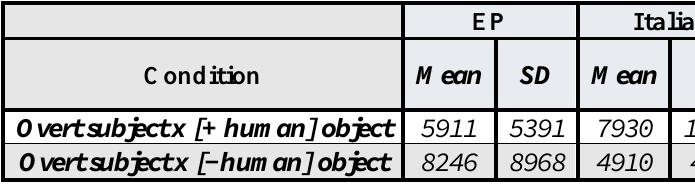
Table 4. Response times (in milliseconds) in the speeded